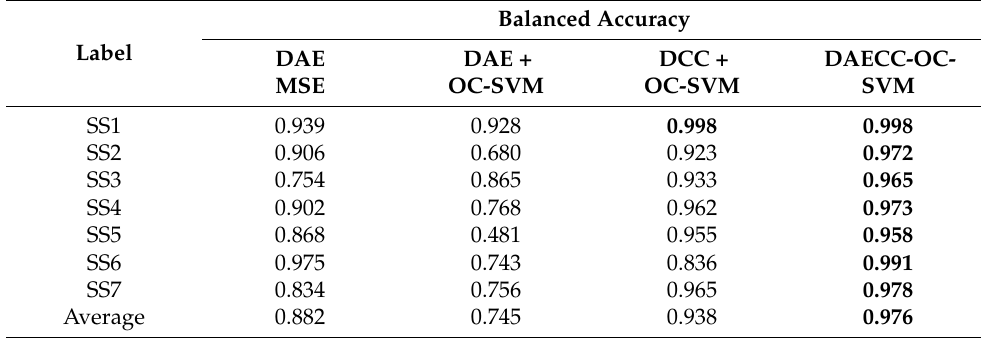
Table 7. Average balanced accuracy over seven scenarios on the CWRU dataset.